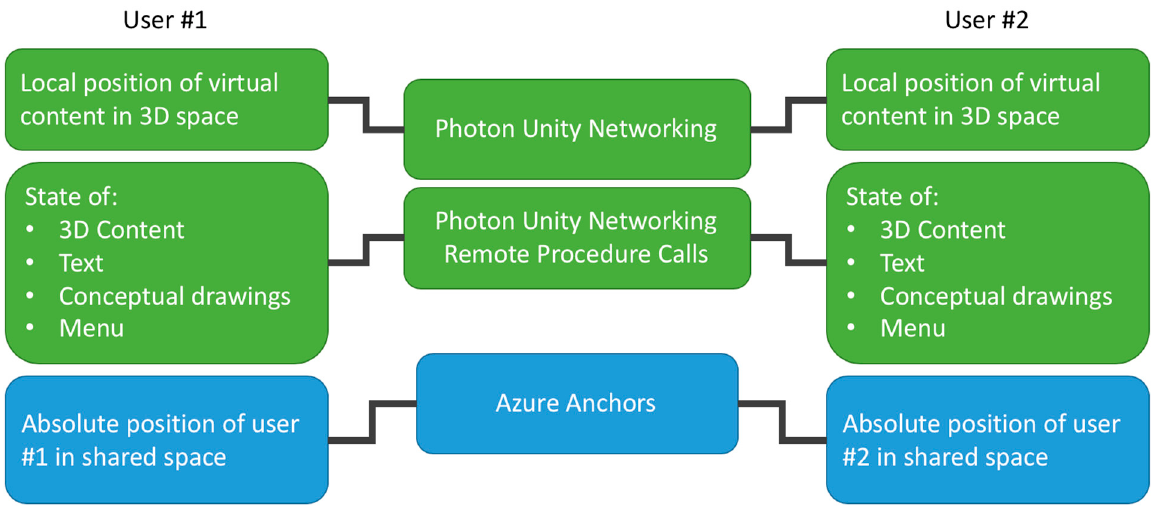
Figure 4. This chart illustrates how the various components of the shared experience are synchronized across two users, with Photon Unity Networking and Remote Procedural calls connecting the content state across two users, and Azure Anchors providing the common coordinate system for to users.